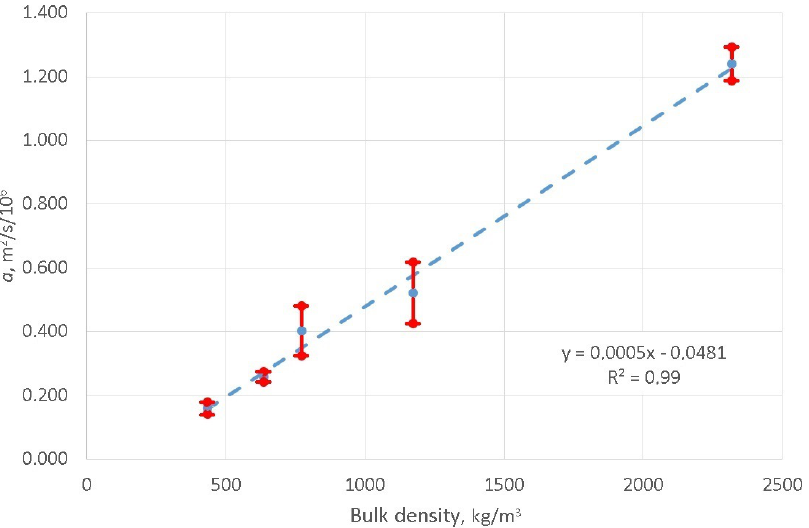
Figure 10. Graph showing the relationship between the bulk density of concrete samples and the a parameter